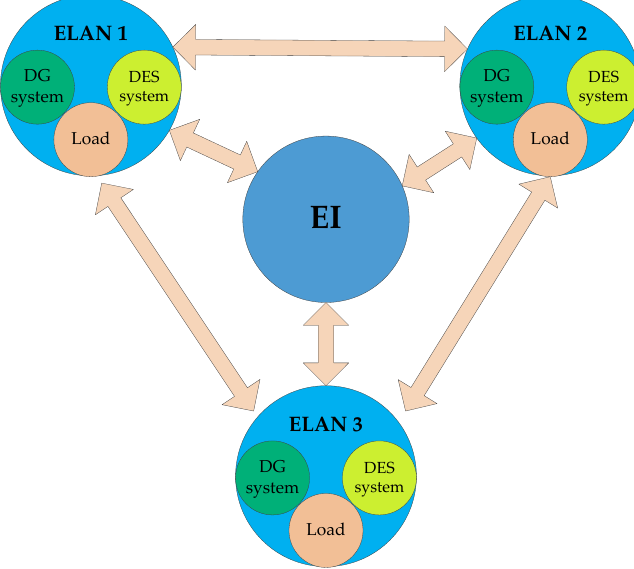
Figure 1. Electricity exchange process of the energy local area network (ELAN).